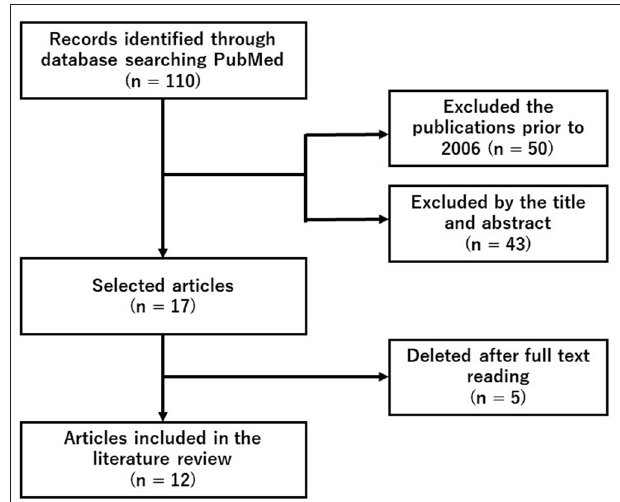
FIGURE 1 | Flowchart representing literature’s search and selection